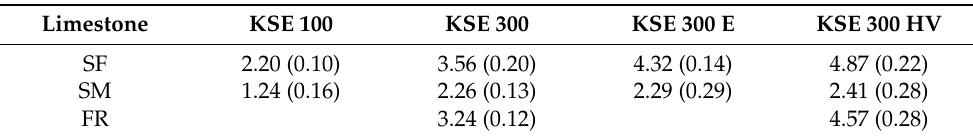
Table 3. Weight change of the limestones due to consolidation (w/w%) (standard deviation of measured data is in